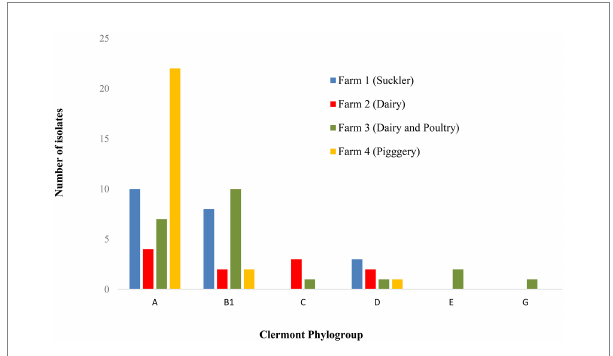
FIGURE 2 Distribution of different E. coli phylogroups amongst the four farms.